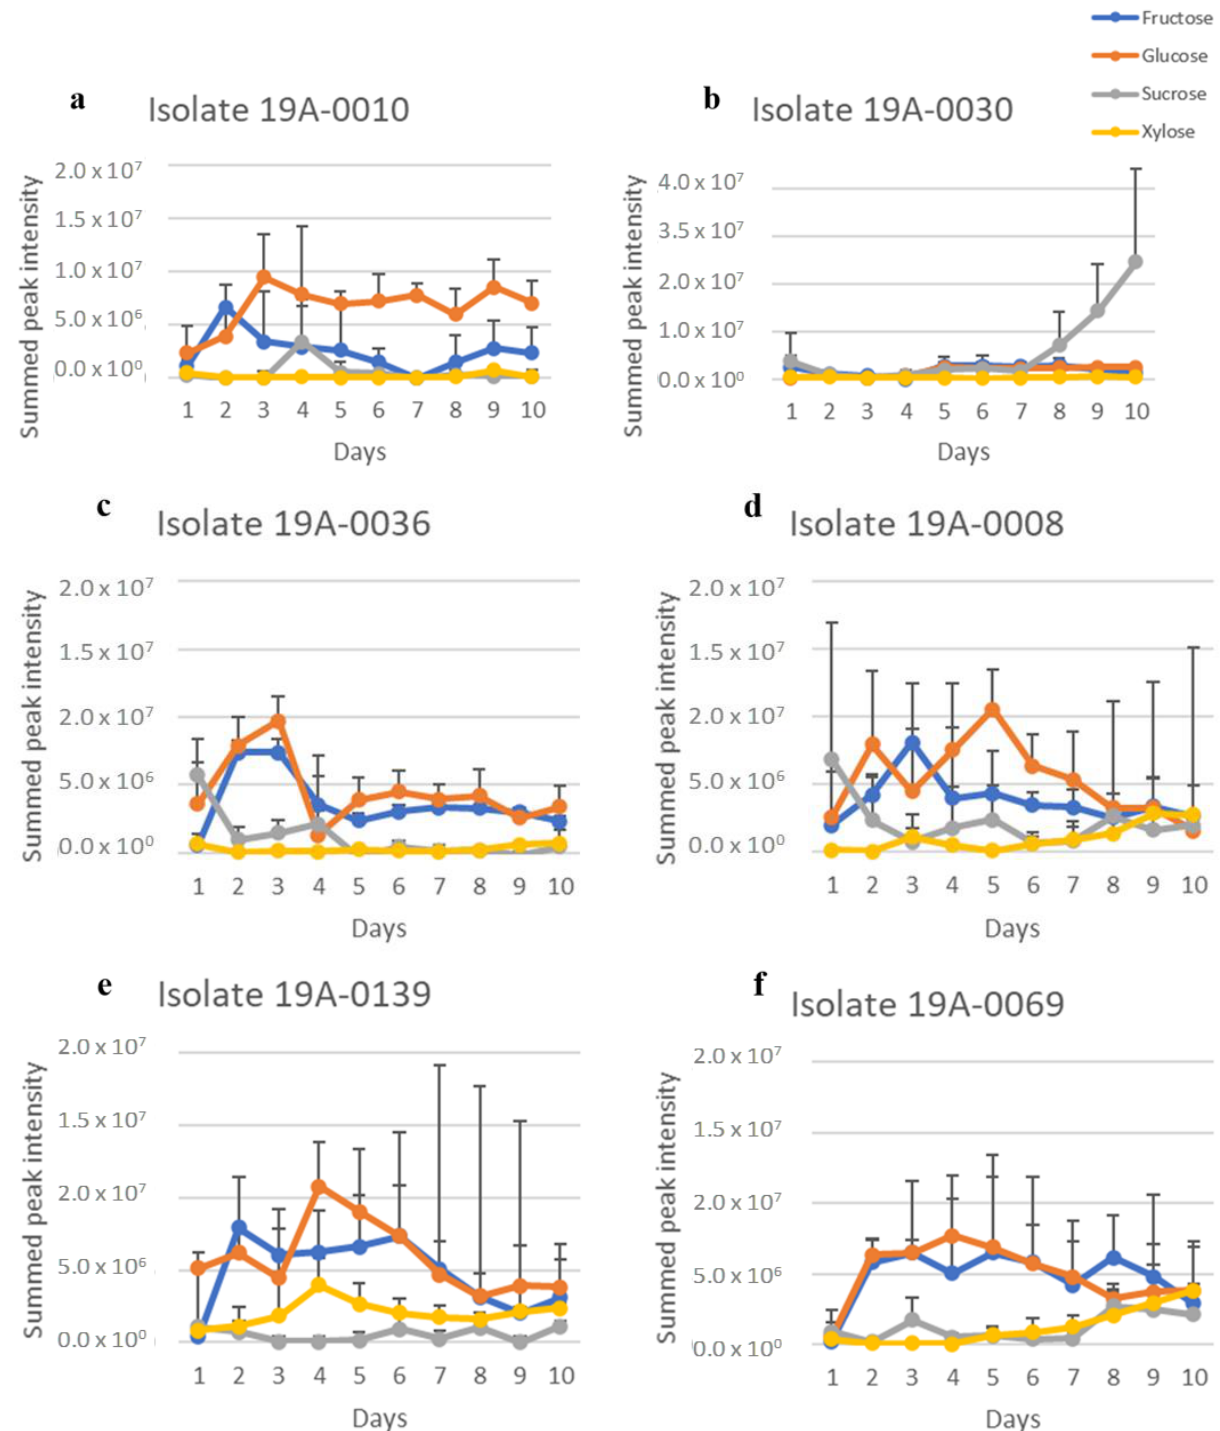
Figure 4. Fumaric acid production of R. stolonifer isolates in the presence of glucose, fructose, sucrose, or xylose, along with asparagine as the nitrogen source. Data presented are the relative concentration of fumaric acid (as determined from NMR) with standard deviation (error bars), n = 3. ( a ) Isolate 19A – 0010, ( b ) isolate 19A – 0030, ( c ) isolate 19A – 0036, ( d ) isolate 19A – 0008, ( e ) isolate 19A – 0139, ( f ) isolate 19A – 0069.